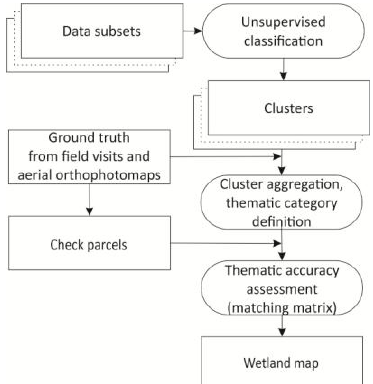
Figure 3. Workflow of thematic processing of the data